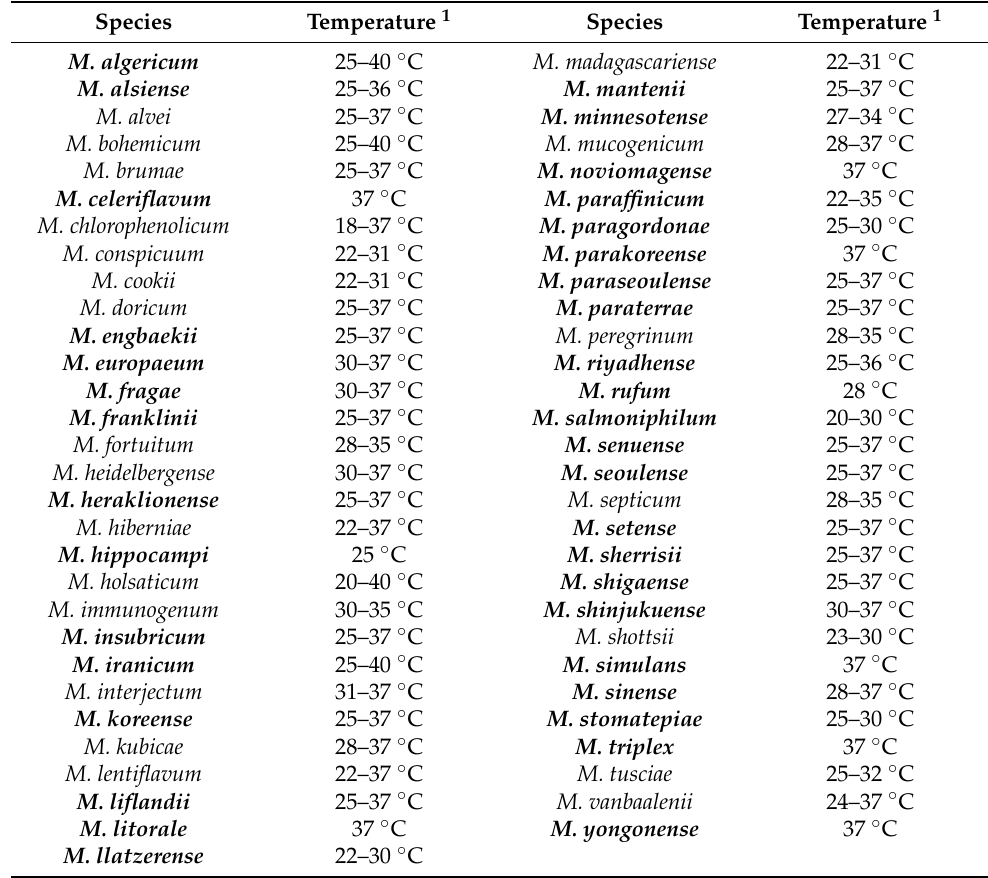
Table 2. Mesophilic nontuberculous mycobacteria. Species Temperature 1 Species Temperature